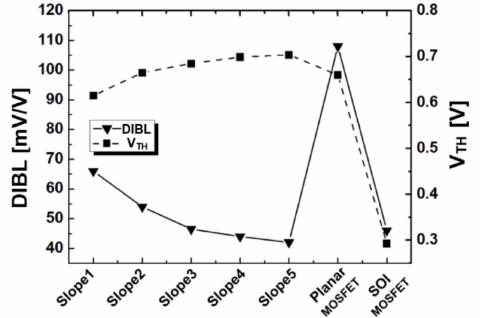
Figure 3. Simulation results for DIBL and threshold voltage for the planar MOSFET, the SOI MOSFET, and PiFETs with a silicon film thickness of 15 nm and the buried insulators (slopes 1–5) of the SiO 2